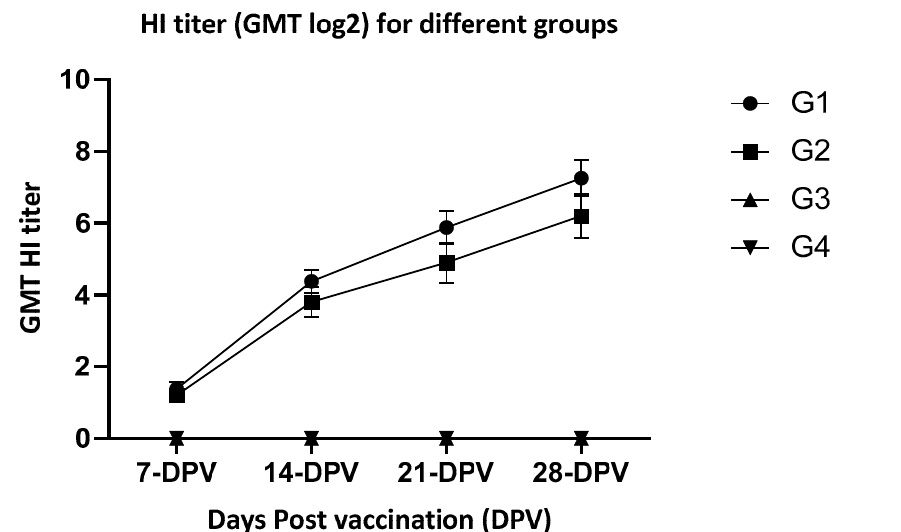
Figure 1. HI titer (GMT log2) for different groups at week 1-, 2-, 3-, 4- post-vaccination. G-1—vaccinated birds under laboratory conditions; G-2—Vaccinated birds under farm conditions; G-3—non-vaccinated birds under laboratory conditions (controls); G-4—non-vaccinated birds under laboratory conditions (controls); and non-detectable level, DPV—days post-vaccination.